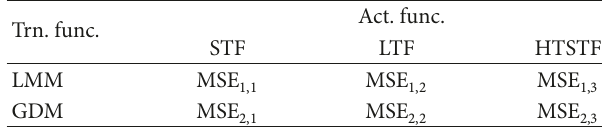
Table 1: Grouped MSEs.